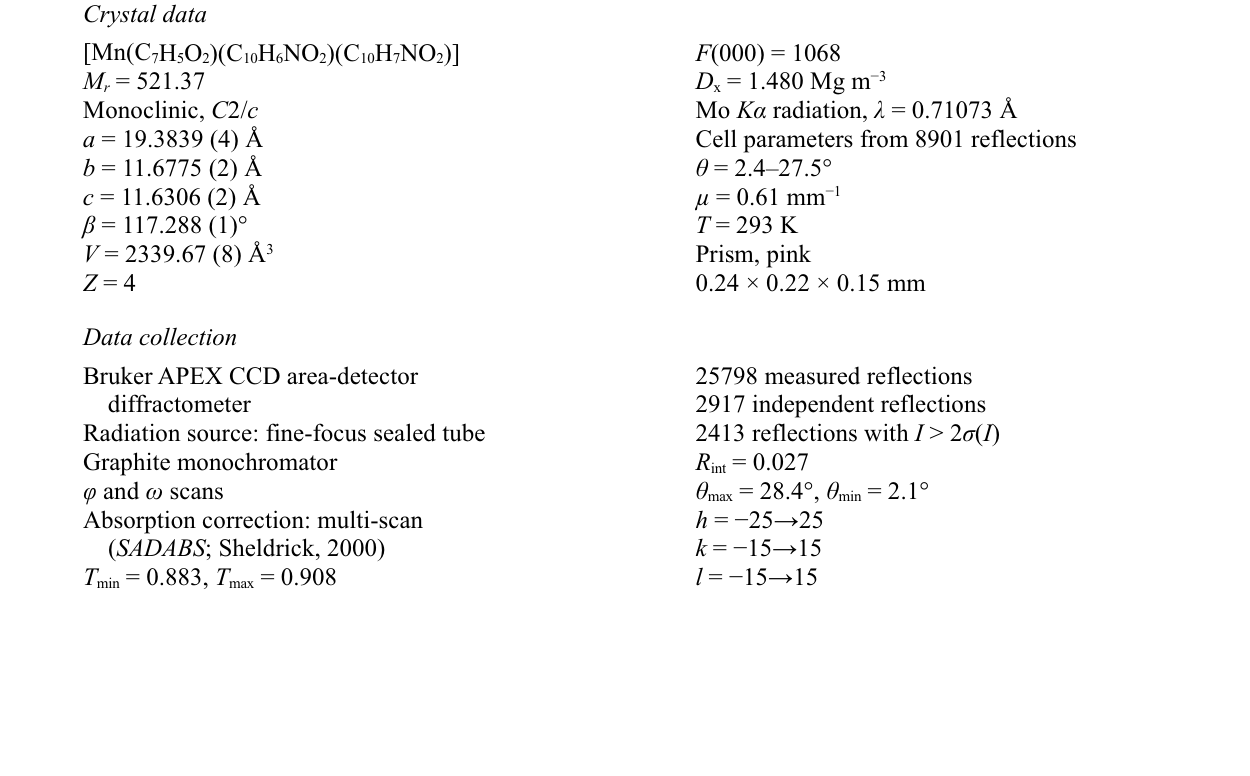
sup-3 Acta Cryst. (2008). E 64 , m258